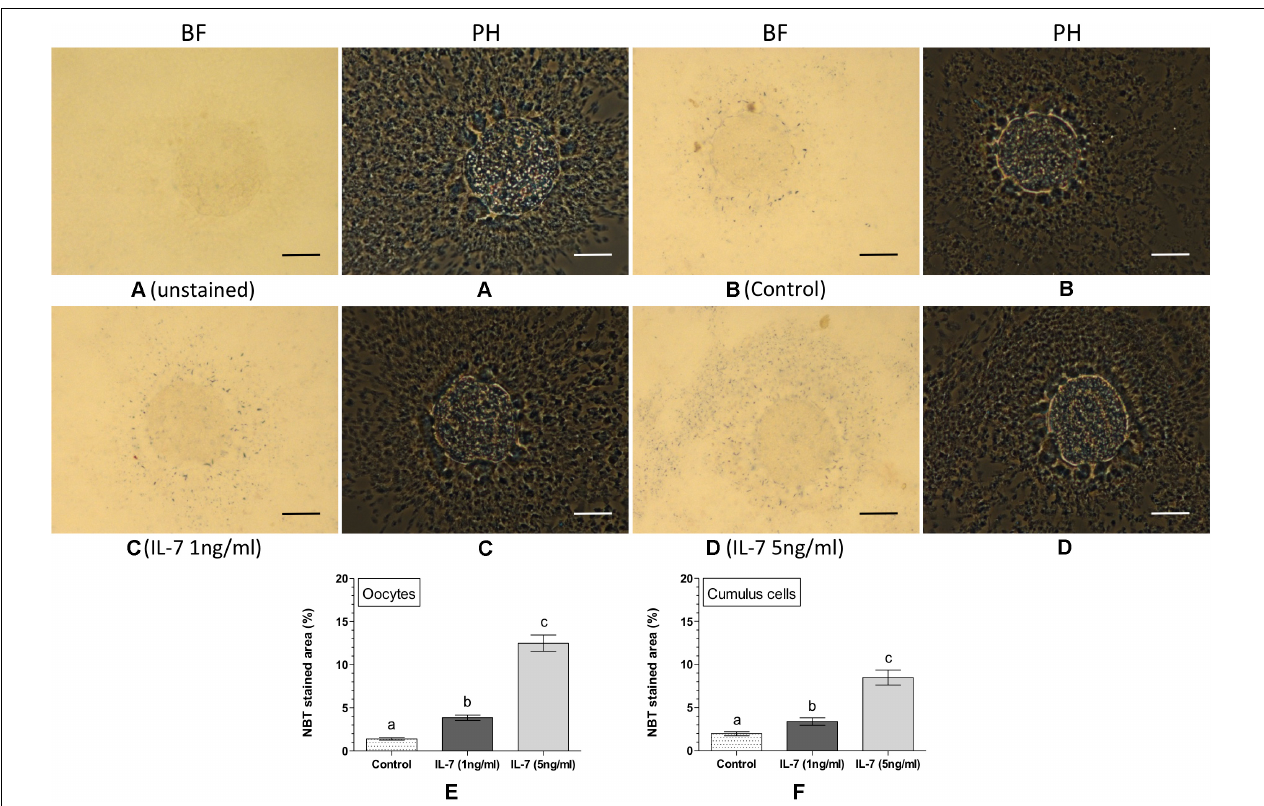
FIGURE 2 | Nitroblue tetrazolium (NBT) staining for assessing intracellular reactive oxygen species (ROS) in oocytes and cumulus cells. Ovine cumulus-oocyte complexes (COC) were matured in vitro without (control) or with IL-7 (1 or 5 ng/ml) supplementation and stained with NBT. The dark purple/blue spots of formazan precipitates represent ROS. The level of intracellular ROS (% NBT stained area, mean ± SE) was determined in oocytes and cumulus cells from five individual COC in each experimental group. (A) unstained COC, control group; (B) NBT-stained COC, control group; (C,D) NBT-stained COC, IL-7 supplemented groups; (E,F) level of intracellular ROS in oocytes and cumulus cells in different experimental groups. Values without a common superscript (a, b, c) above error bar differ significantly ( P < 0.05). BF, bright-field image; PH, phase-contrast image. Scale bar = 50 µ m.